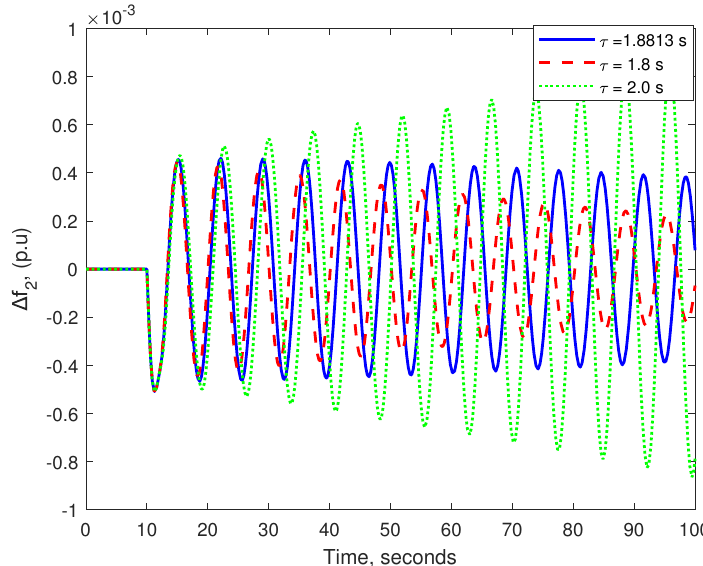
Figure 15. The frequency deviation in the second